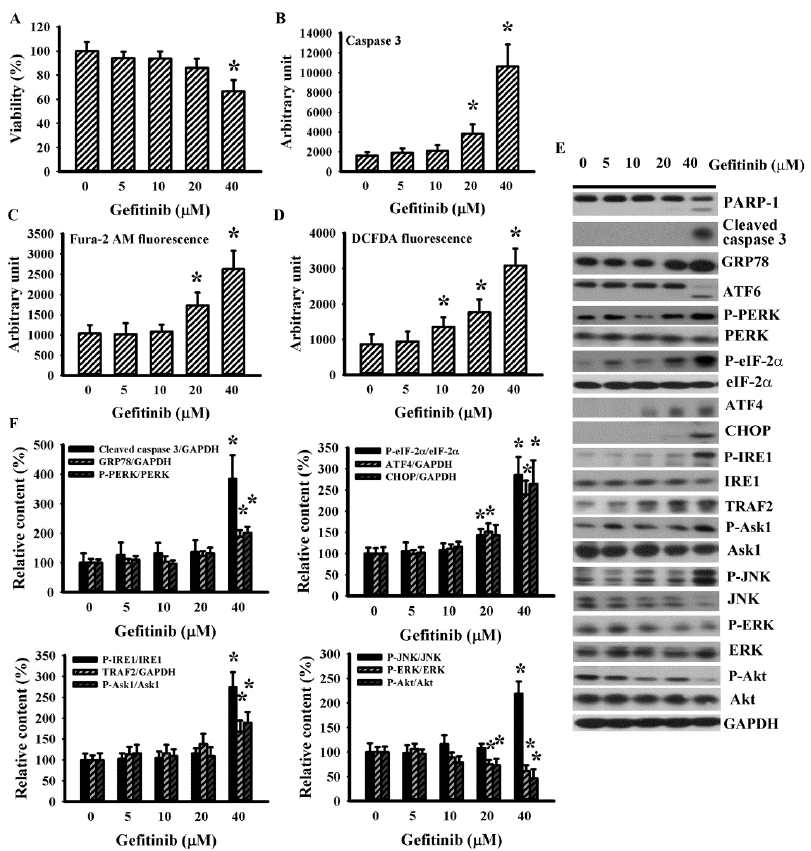
Figure 1. Gefitinib caused apoptosis and Endoplasmic Reticulum (ER) stress in H4 cells. H4 cells were treated with various concentrations of gefitinib (0–40 μM). Cell viability (24 h) was measured with the alamarBlue assay ( A ). Caspase 3 activity (6 h) was measured with enzymatic assay ( B ). Intracellular free Ca 2+ (6 h) was measured with Fura-2 AM fluorescence ( C ). Reactive Oxygen Species (ROS; 6 h) was measured with DCFDA fluorescence ( D ). Protein extracts (6 h) were subjected to Western blot with indicated antibodies. Representative blots ( E ) and quantitative data ( F ) of three independent experiments are shown. Protein contents were normalized with corresponding total protein or GAPDH. * p < 0.05 vs. untreated control, n = 4 ( A – D ).